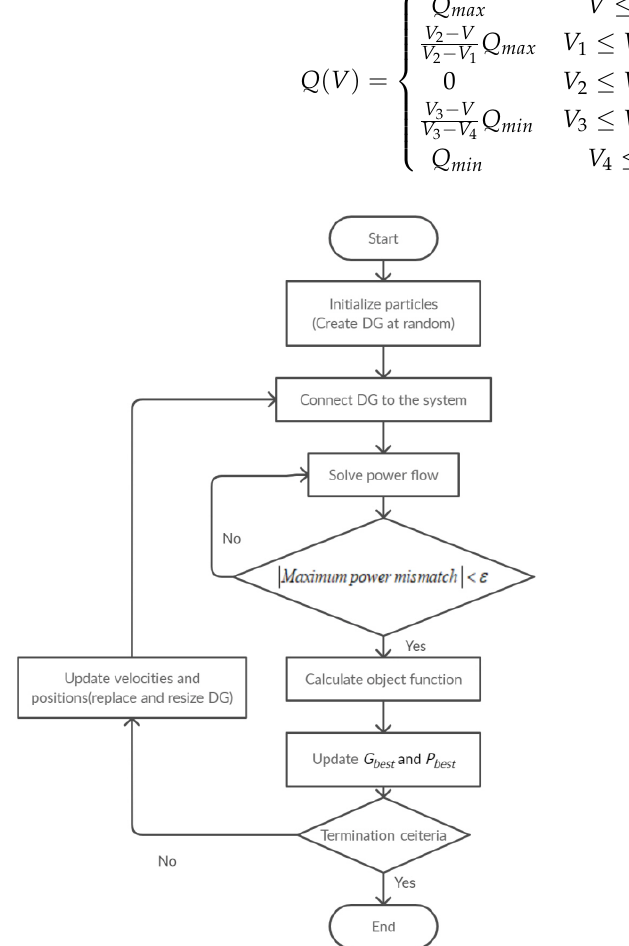
Figure 1. Flowchart of the proposed PSO.